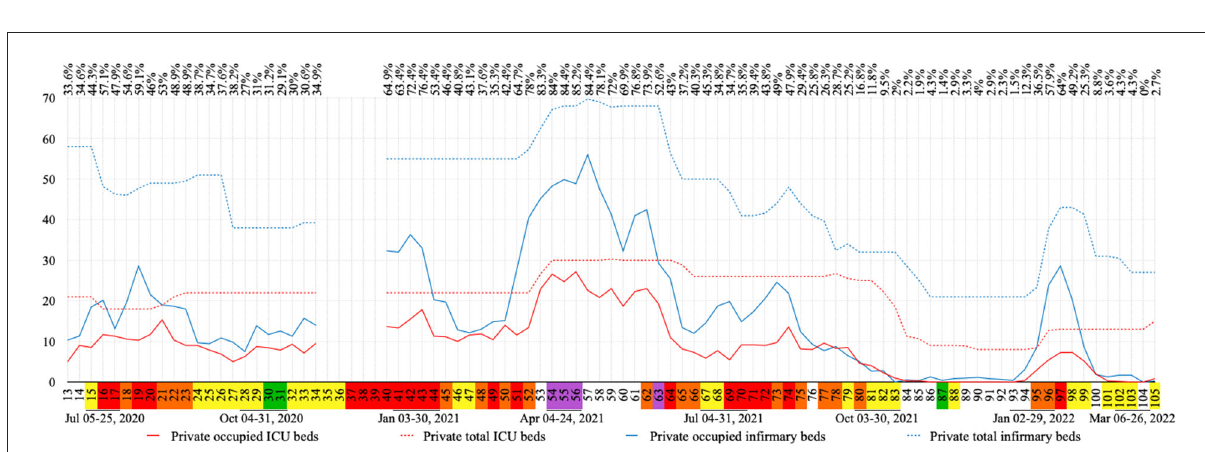
FIGURE7 COVID-19 exclusive private bed occupation per week in absolute numbers. In the line above the graph, is the total occupation percentage for COVID-19 exclusive beds (infirmary and ICU) in private hospitals. Flag colors: Green, very low; yellow, low; orange, moderate; red, high; purple, very high risk. ICU, intensive care